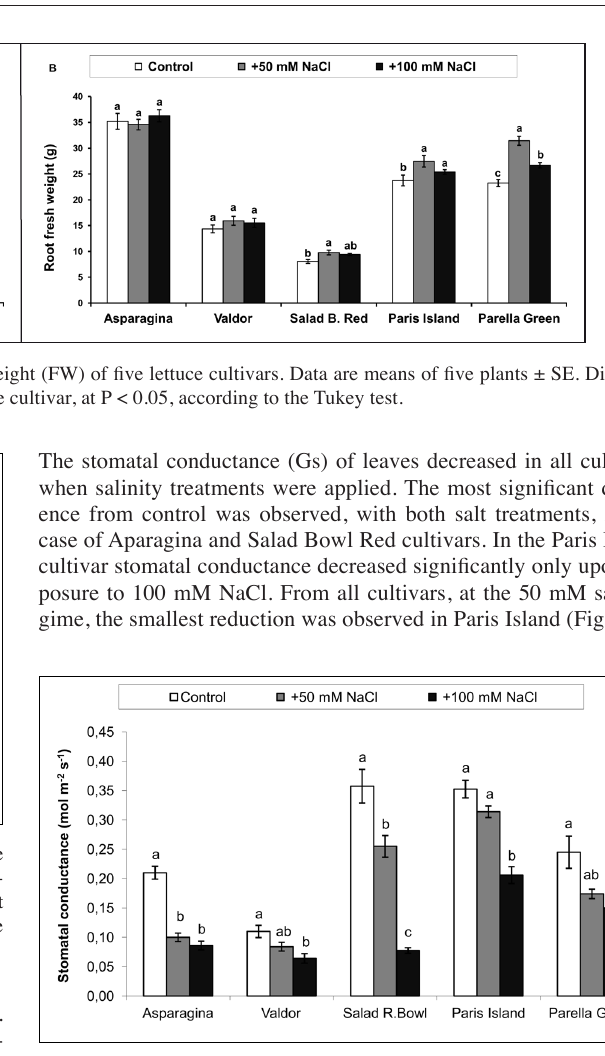
Fig. 4: Stomatal conductance (G s ) in leaves of five lettuce cultivars exposed to different degrees of saltstress. Bars represent means ± SE, n = 5. Different letters indicate significant differences among treatments of the same cultivar, at P < 0.05, according to the Tukey